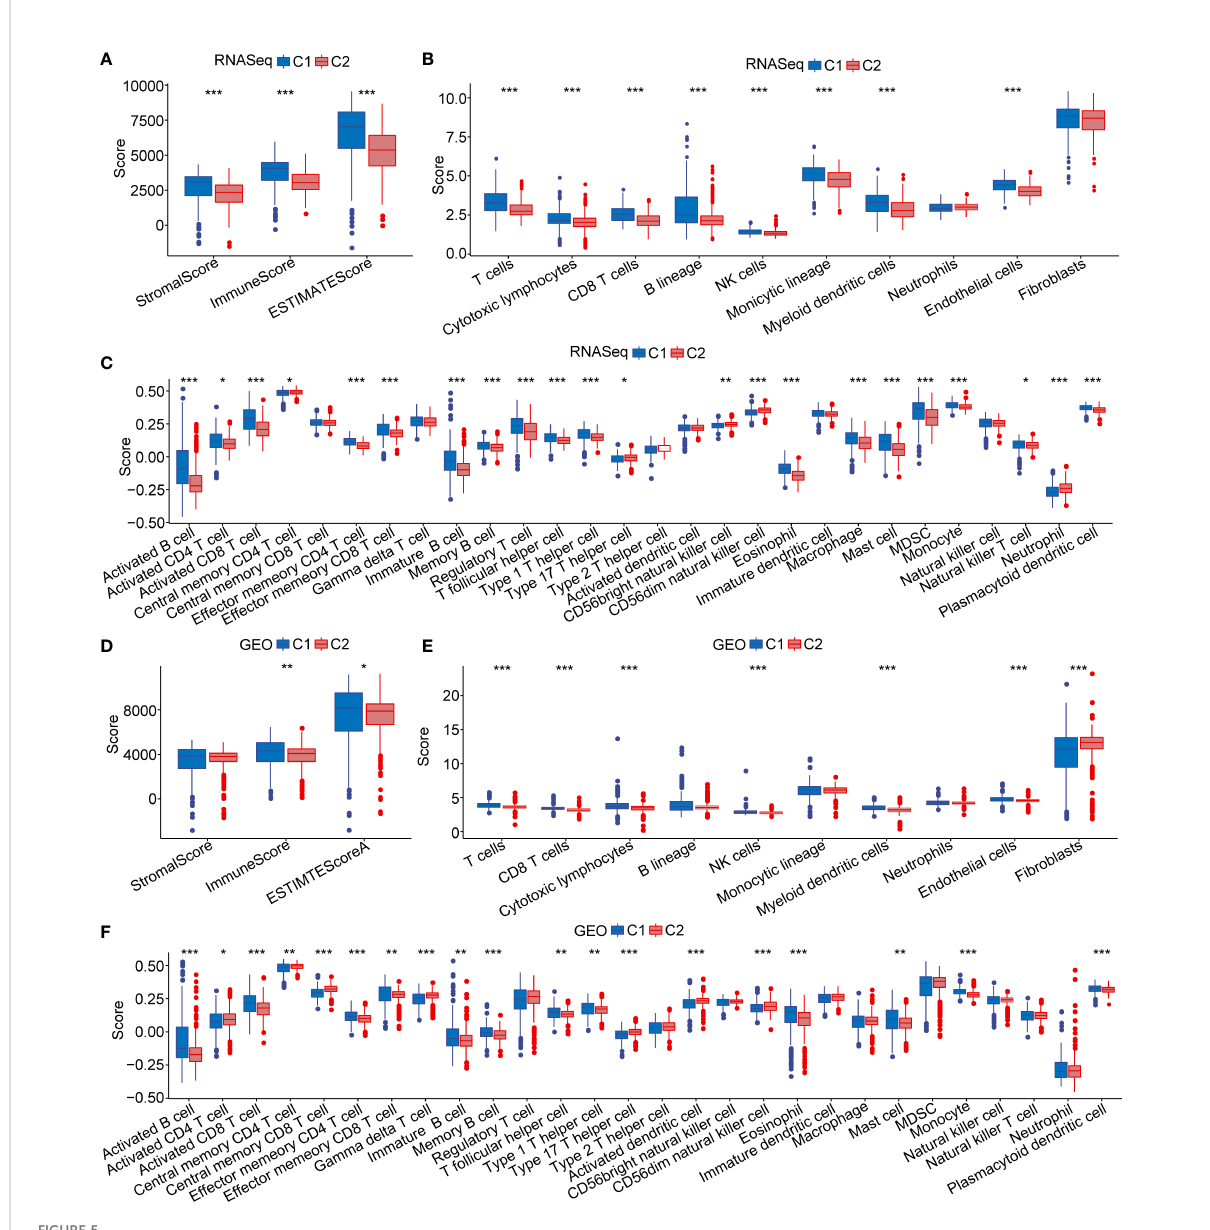
FIGURE 5 Immune microenvironment score. (A – C) The distribution of immune microenvironment score in RNA-seq dataset. (D – F) The distribution of immune microenvironment score in GEO database. * p < 0.05; ** p < 0.01; *** p <